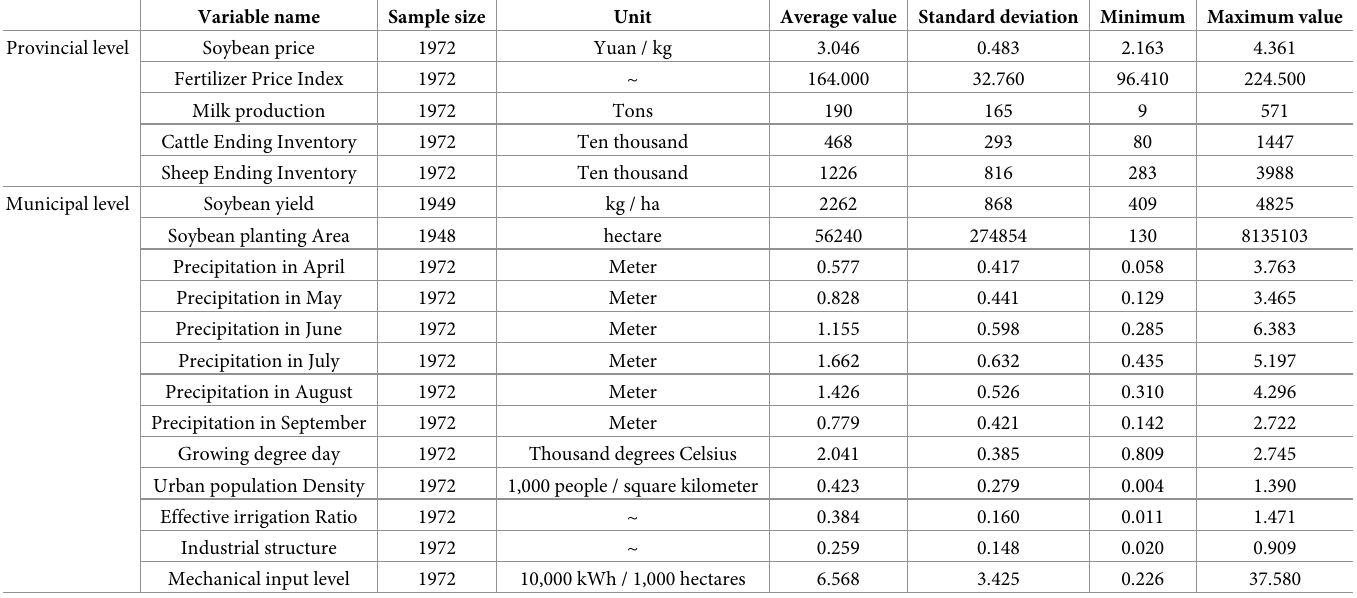
Table 1. Descriptive statistics of each variable.